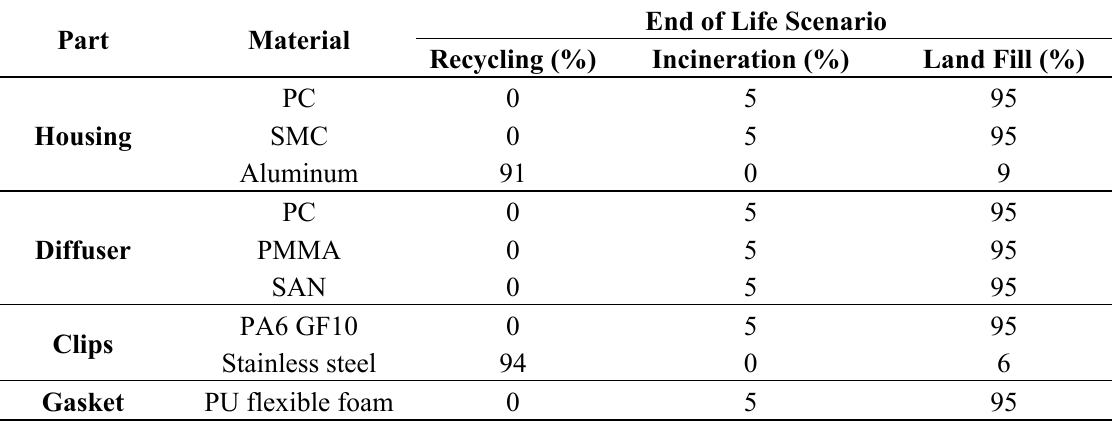
Table 5. End of life Scenario 1.